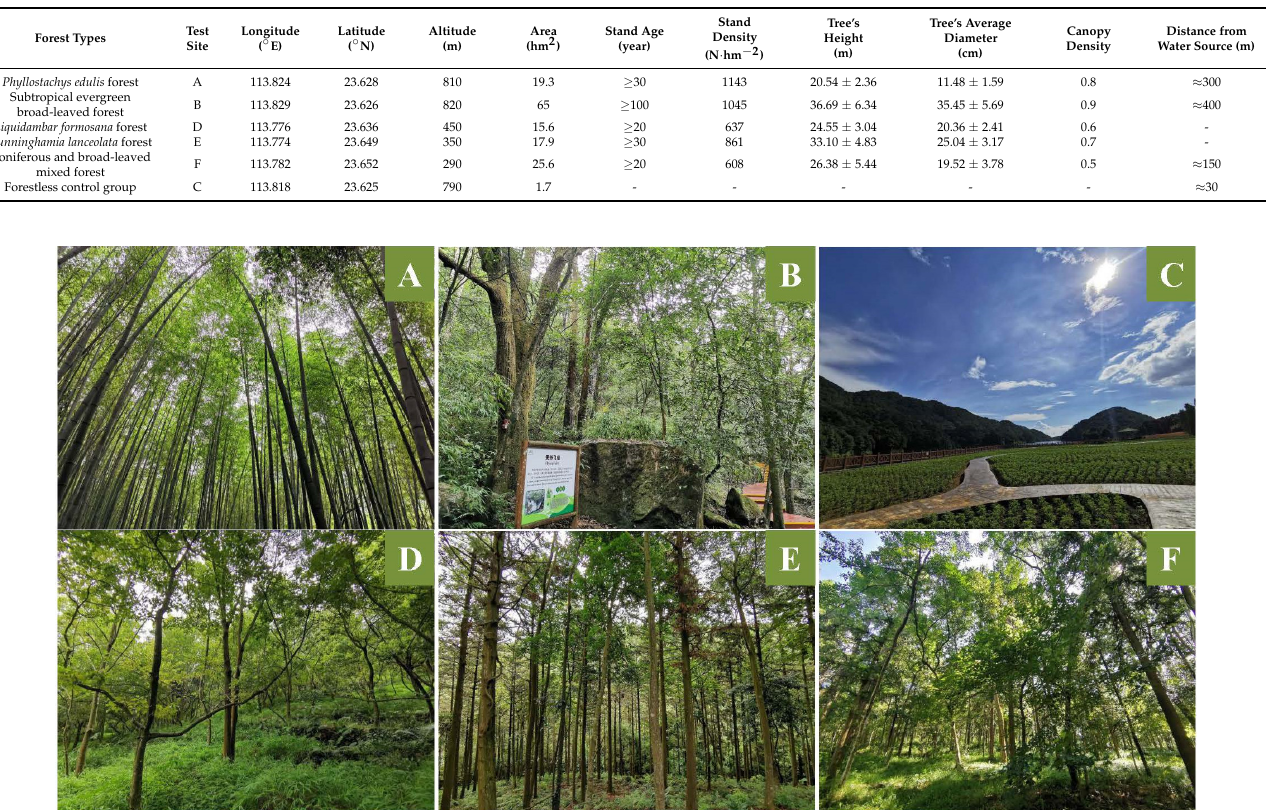
Figure 2. Sample plots of the Shimen National Forest Park. ( A ) Phyllostachys edulis forest; ( B ) Subtropical evergreen broad-leaved forest; ( C ) Forestless control group; ( D ) Liquidambar formosana forest; ( E ) Cunninghamia lanceolata forest; ( F ) Coniferous and broad-leaved mixed forest.